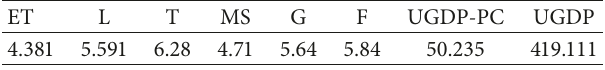
Table 3: Optimum values of factors and response variables.